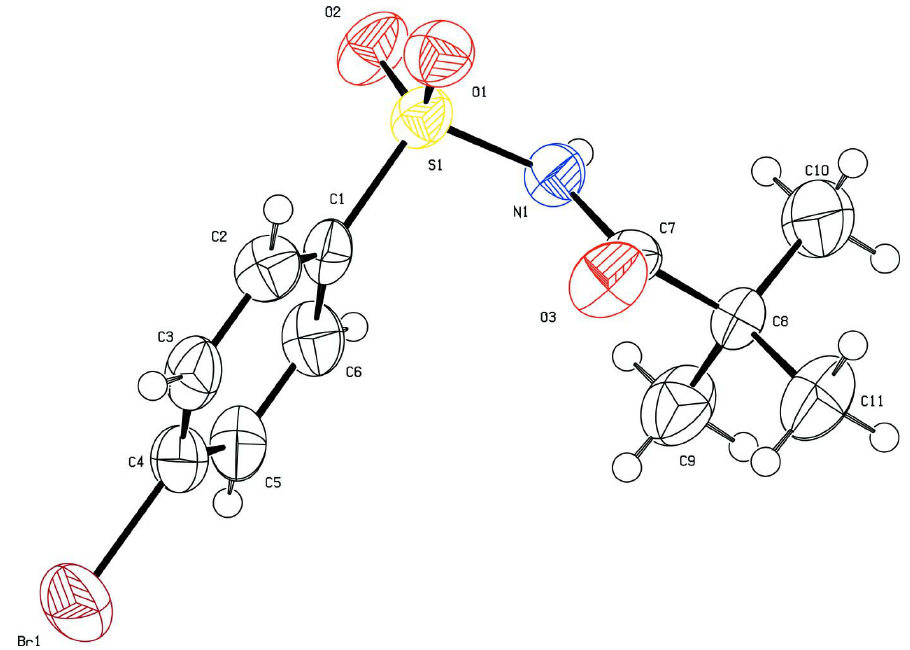
Figure 1 Molecular structure of the title compound, showing the atom labelling scheme. The displacement ellipsoids are drawn at the 50% probability level. H atoms are represented as small spheres of arbitrary radii.